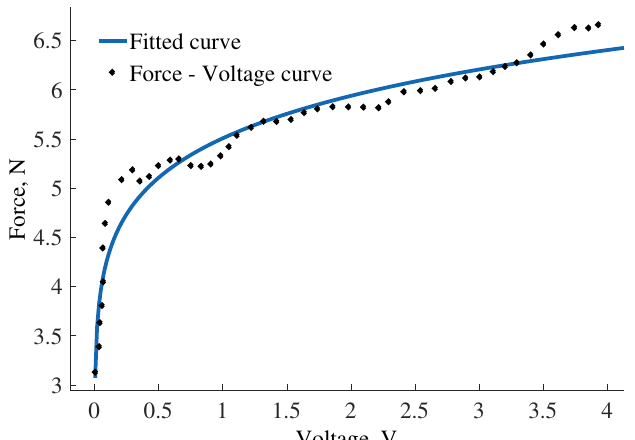
Figure 10. Calibration curve for tactile elements with spring rate 0.2 N/mm-fitted line and force-voltage